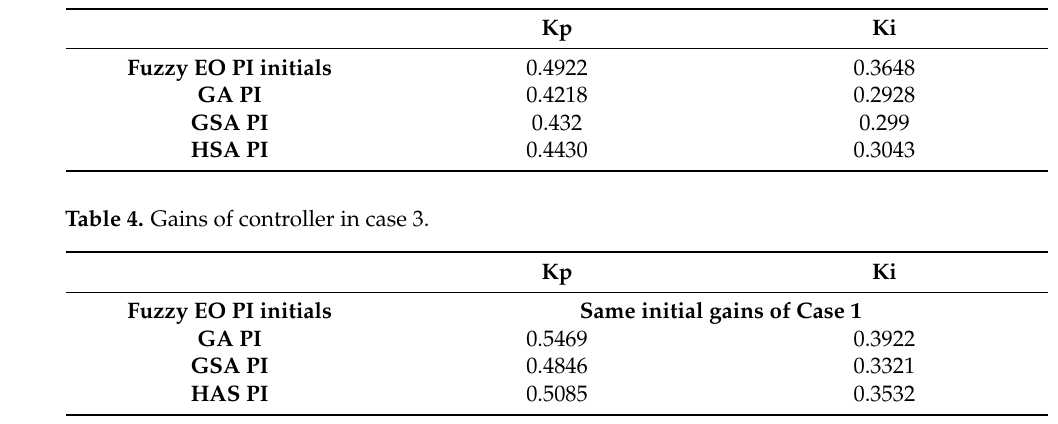
Figure 18. Change in area 1 frequency under 1% load change in area 1.